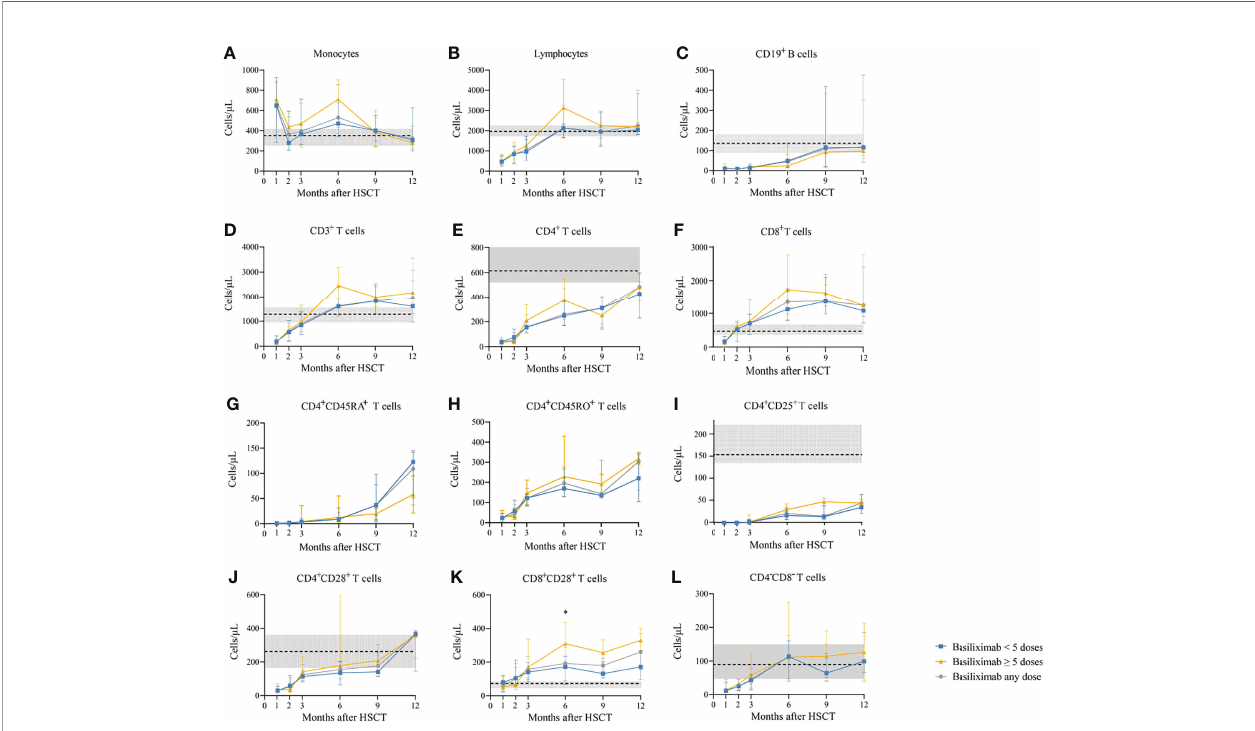
FIGURE 4 | (A-L) Kinetics of immune reconstitution in grade III – IV SR-aGVHD patients who showed an ORR after basiliximab treatment. Because of lack of data about CD4 + CD45RA + T cells and CD4 + CD45RO + T cells in healthy donors, the values of these two immune cell subsets in healthy donors are not shown. Data are shown as median absolute counts with error bars indicating the 25th – 75th percentiles. The horizontal dotted lines represent the median value of healthy cohorts, and the gray areas represent the 25th – 75th percentiles for the healthy cohorts. * P < 0.05, basiliximab <5 doses vs. basiliximab ≥ 5 doses. ORR, overall response rate; SR-aGVHD, steroid-refractory acute graft-versus-host disease.